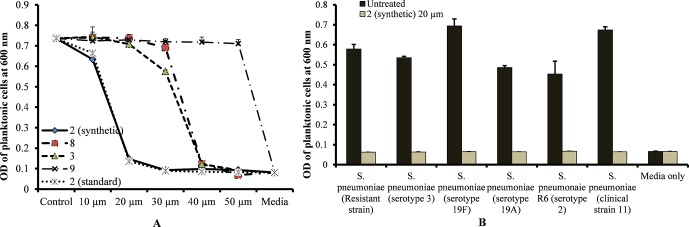
Detection of minimum inhibitory concentrations (MICs) of viniferin compounds against S. pneumoniae. (A) MIC detection of standard and synthetic viniferin compounds (2, 3, 8, and 9) tested from 10 to 50 µm against S. pneumoniae D39 (serotype 2). (B) Inhibitory effect of synthetic ε-viniferin (2) (20 µm) on S. pneumoniae antibiotic resistance strain and different serotypes. Bacterial growth in the presence of viniferin was measured via optical density at 600 nm after 18 h. The means were calculated. Error bars represents standard deviations.